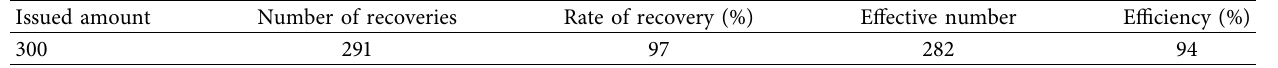
Table 2: Distribution statistics of mental health